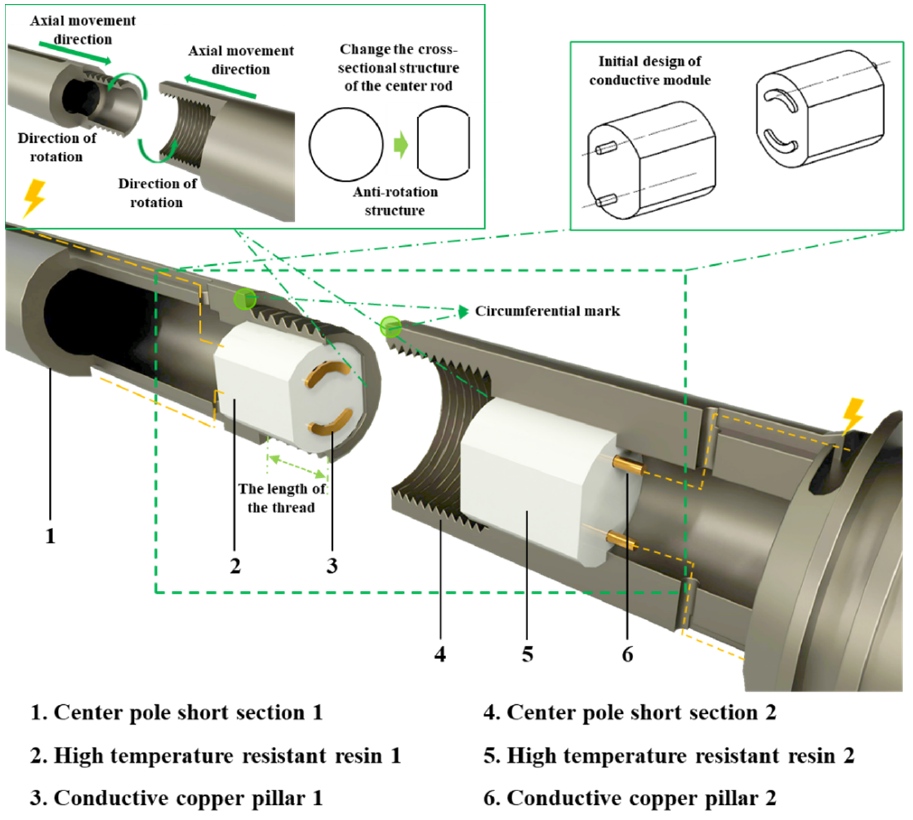
Figure 10. Conceptual design drawing of the conductive center pole. Set the elements in the design matrix A to X . It can be seen from the mapping rela- tionship between the functional requirement vector { FR } and the design parameter vector { DP } that the connection of the conductive module is related to the position of the center pole circumferential mark, the thread length, and the angle of the anti-rotation structure. Therefore, the design parameter DP 1 is related to the design parameters DP 2 and DP 3 , and the design parameter DP 2 is related to the design parameter DP 1 and DP 3 . The design matrix A is as follows: